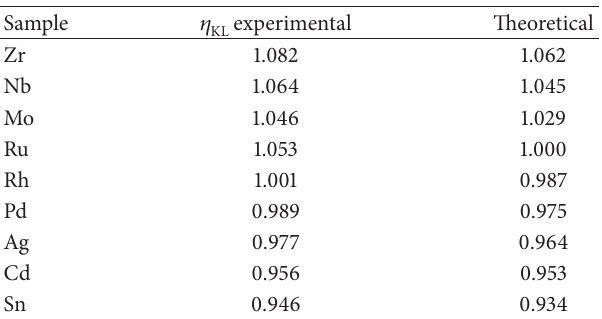
Table 5: K-L total vacancy transfer.